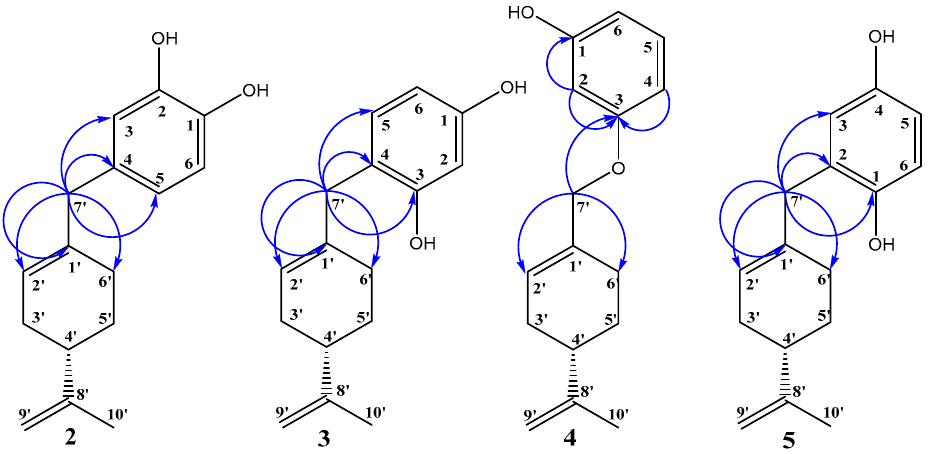
Figure 1. Most important correlations 2D 1 H– 13 C HMBC of compounds 2 – 5 .